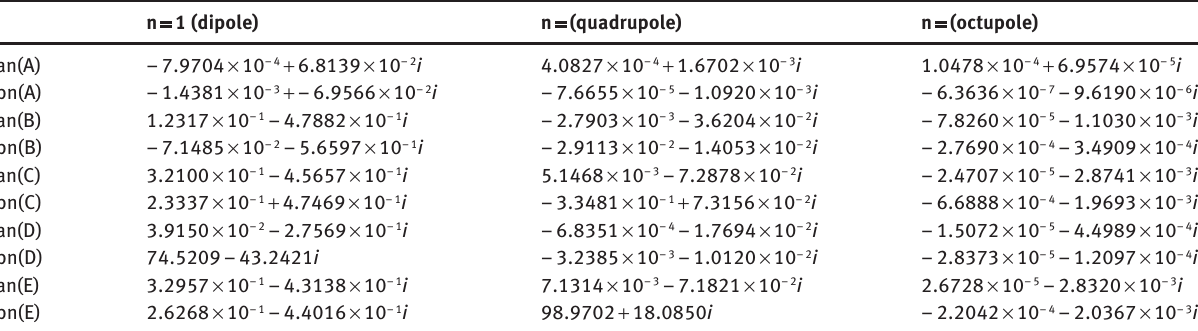
Table 1: Calculated results of the first six electric (a points displayed in Figure